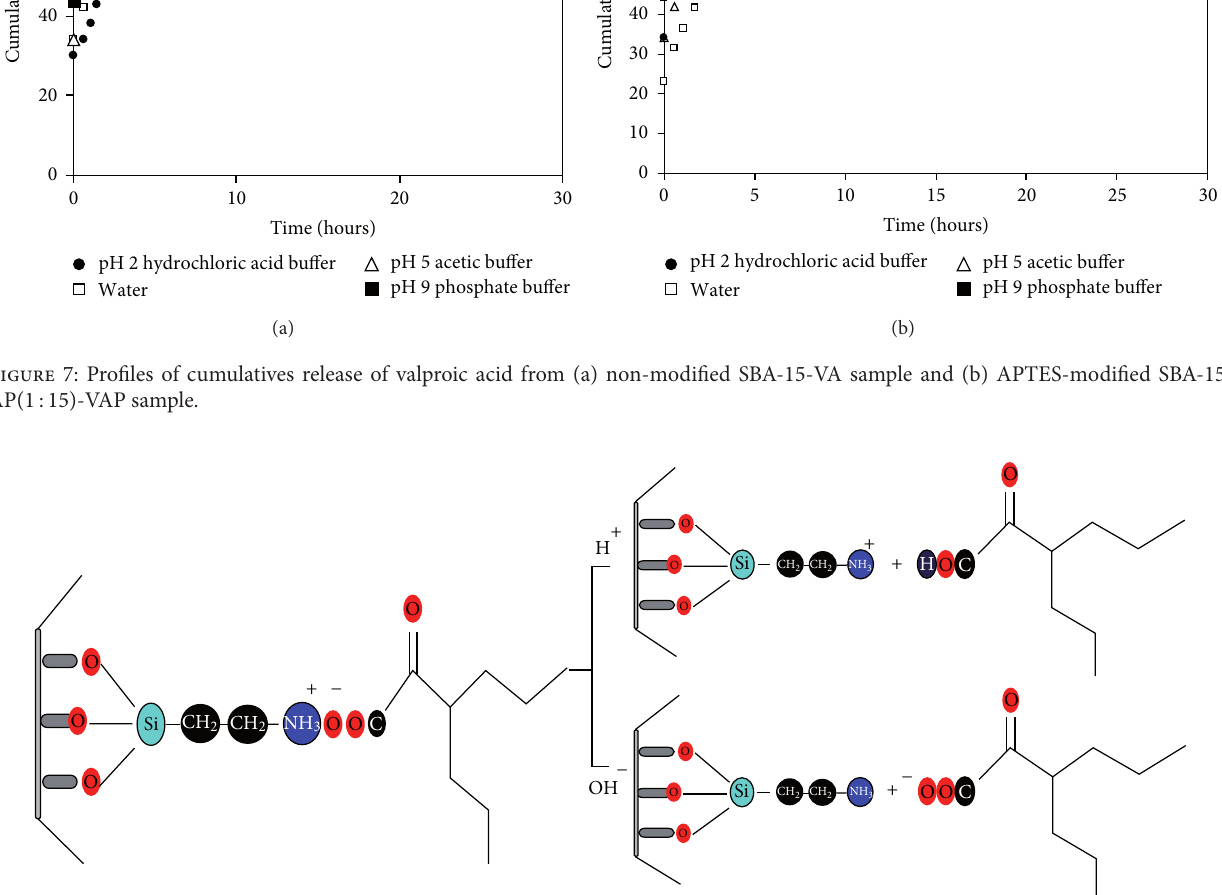
SBA-15 Valproic acid F 8: �rug mechanism release of valproic acid from aminopropyl-modi�ed SBA-15 in acidic and basic media.